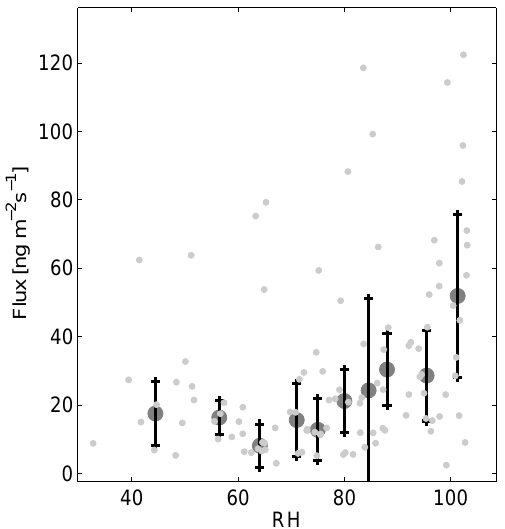
Figure 7. Temperature and PPFD classified (12 ◦ C ≤ T ≤ 15 ◦ C and PPFD ≤ 50µmolm − 2 s − 1 ) monoterpene fluxes (grey circles, bin-medians, n = 15) from May-Aug (years 2010–2013) as a func- tion of relative humidity (RH). Thick black lines represent 95% confidence intervals of the medians, and grey dots are the measured fluxes.